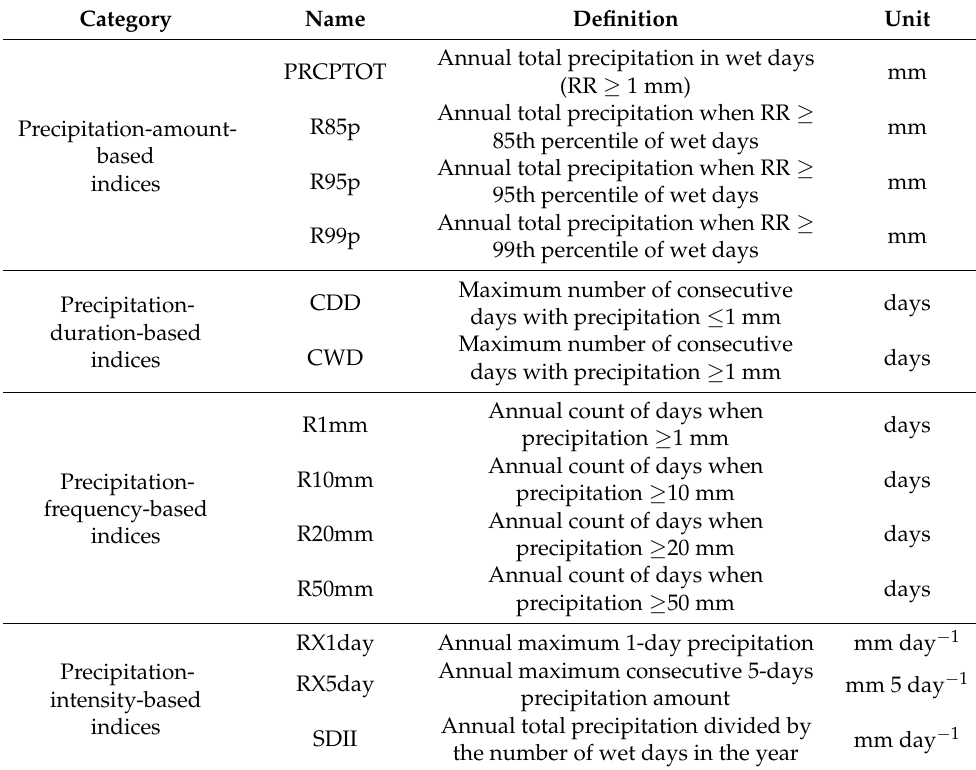
Table 1. List of the selected 13 extreme indices from ETCCDI used in this